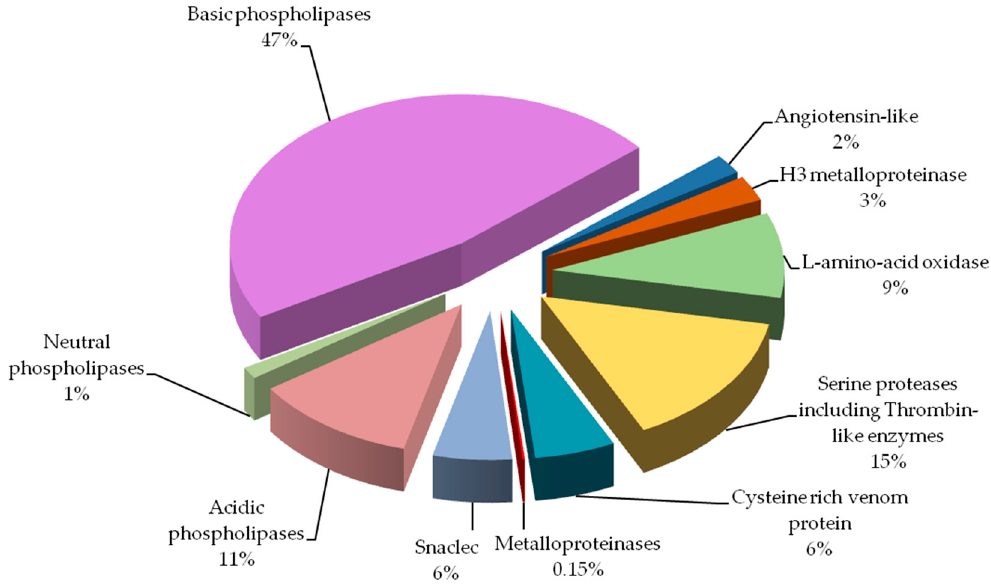
Figure 3. Protein groups of Vipera berus berus venom. Each group is represented as a percent fraction of the particular protein spots present on the gels.